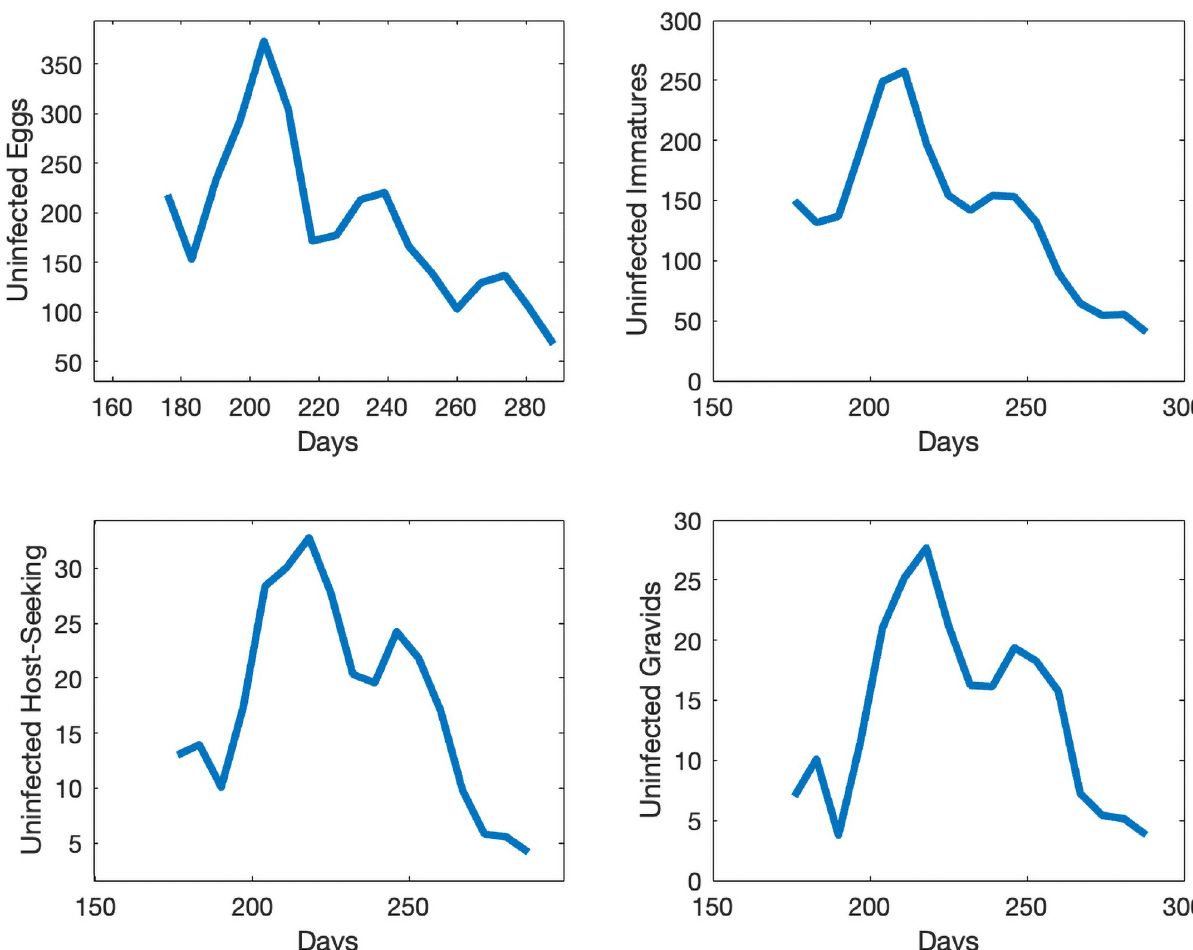
Fig 5. Simulations of individuals in the uninfected compartments for the infection model at different life stages in Knoxville,